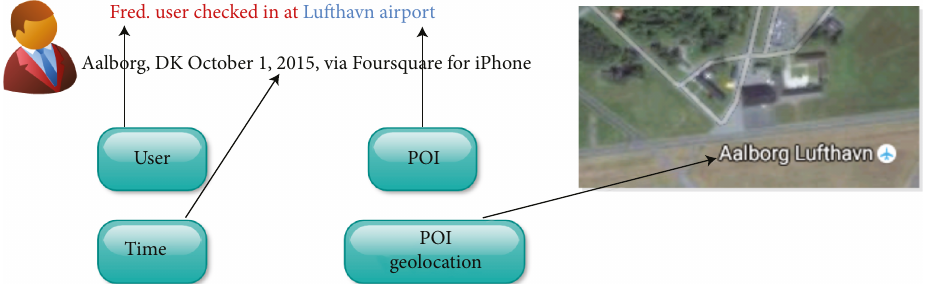
Figure 1: An example of